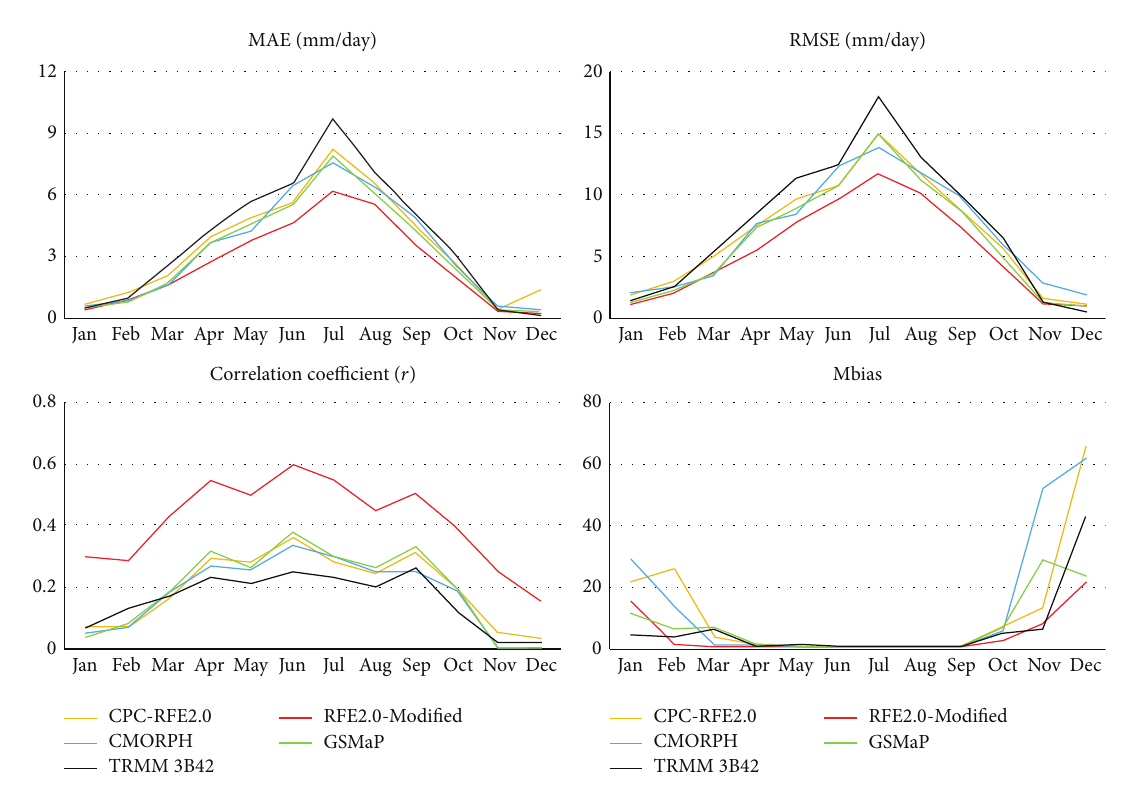
Figure 5: Monthly average of daily error statistics of different satellite products (G-G